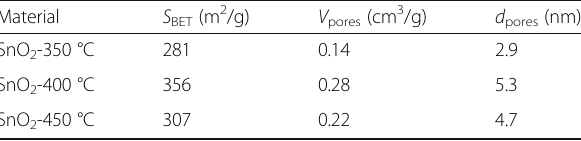
Table 1 The textural characteristics of all samples Material S BET (m 2 /g) V pores (cm 3 /g) d pores